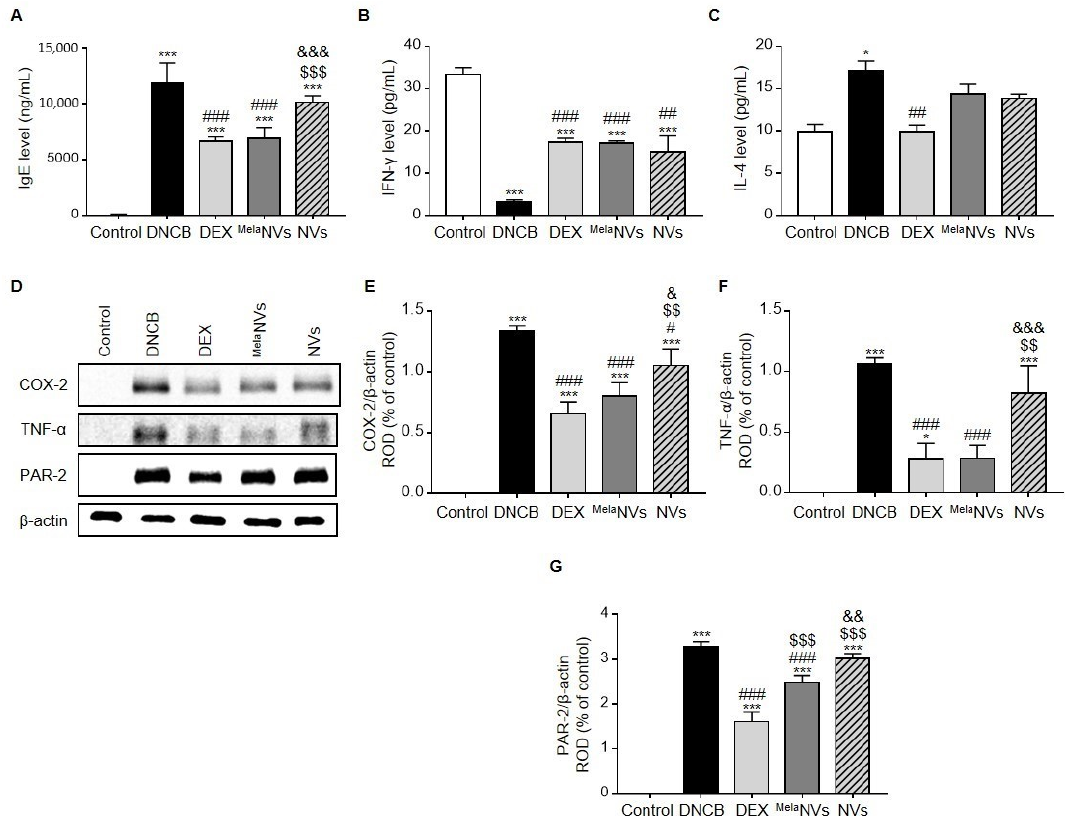
Figure 5. Effect of Mela NVs on serum IgE, IFN- γ , and IL-4 levels and on the expression of pro-inflammatory cytokines in AD-like skin lesions. ( A ) Serum IgE levels after treatment of DEX or Mela NVs or NVs in DNCB-induced AD mice ( n = 5). ( B , C ) Serum levels of IFN- γ ( B ) and IL-4 ( C ) determined by using ELISA ( n = 5). ( D – G ) Western blot analysis of COX-2, TNF- α , and PAR-2 in dorsal AD-like skin lesions in the respective experimental groups. Protein expression was measured relative to β -actin with densitometry. Data are presented as mean ± SEM. * p < 0.05, *** p < 0.001 vs. control, # p <